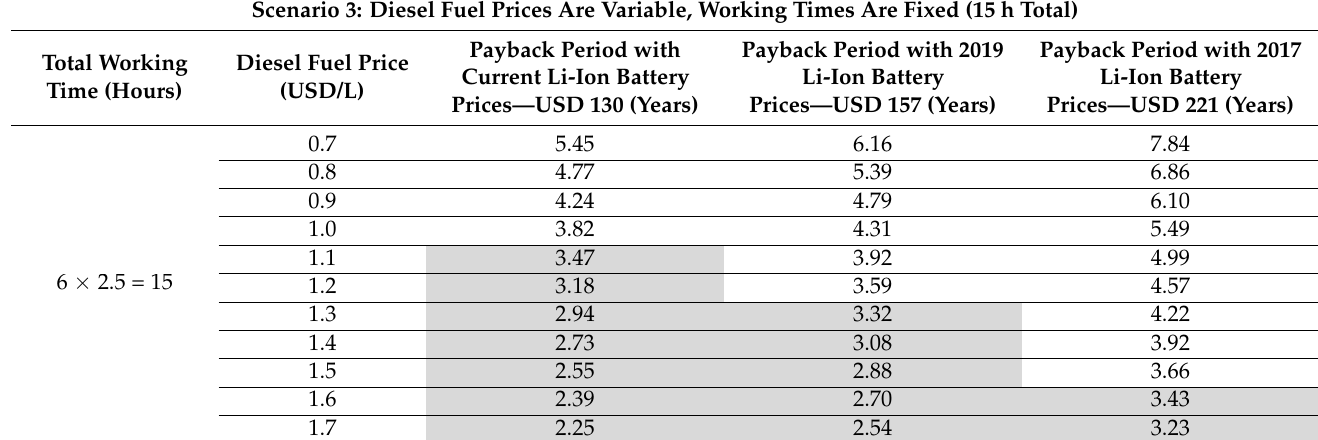
Table 4. Payback time with varying diesel fuel prices (scenario